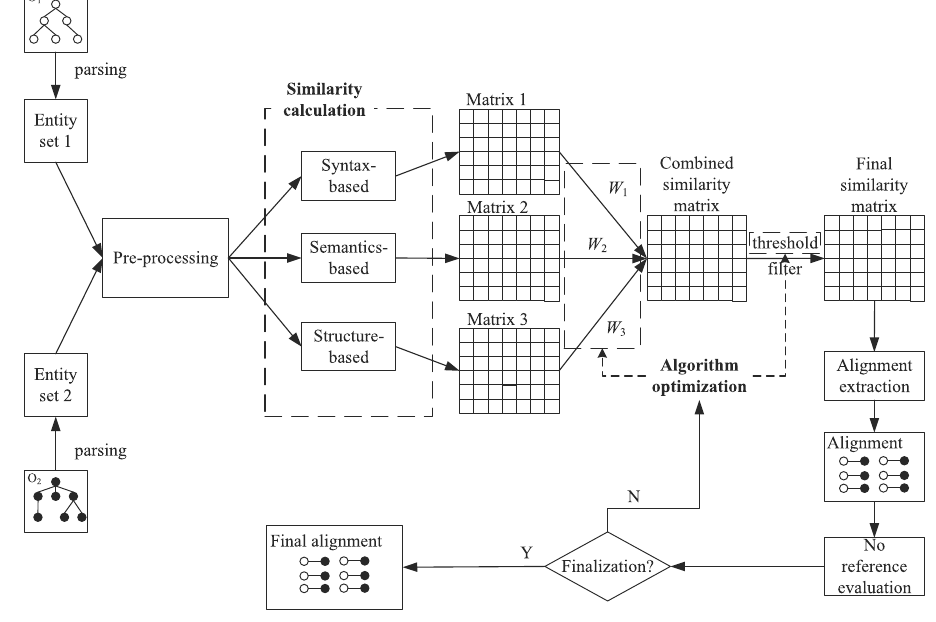
Fig. 3 The flow chat of ontology meta-matching process